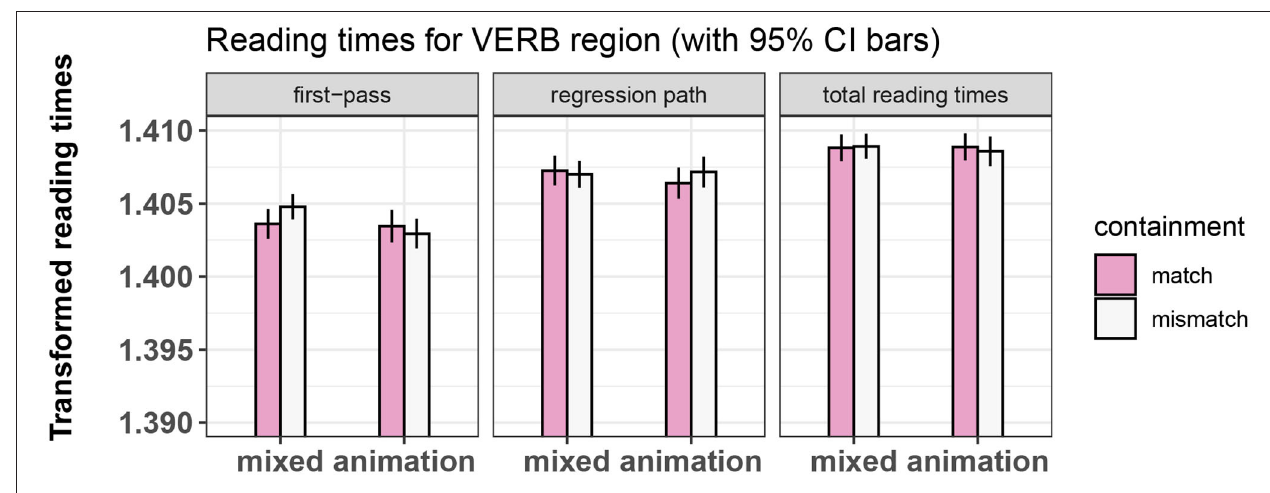
FIGURE 5 | Summary of results for the VERB region, Experiment